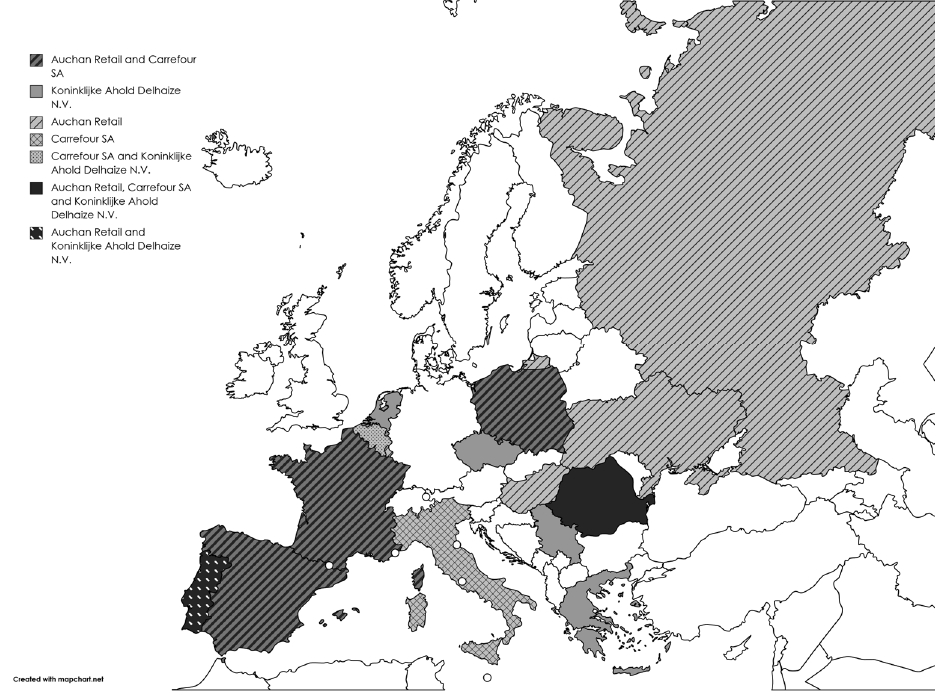
Figure 2. Retailers’ presence in Europe. Source: own construction using MapChart.